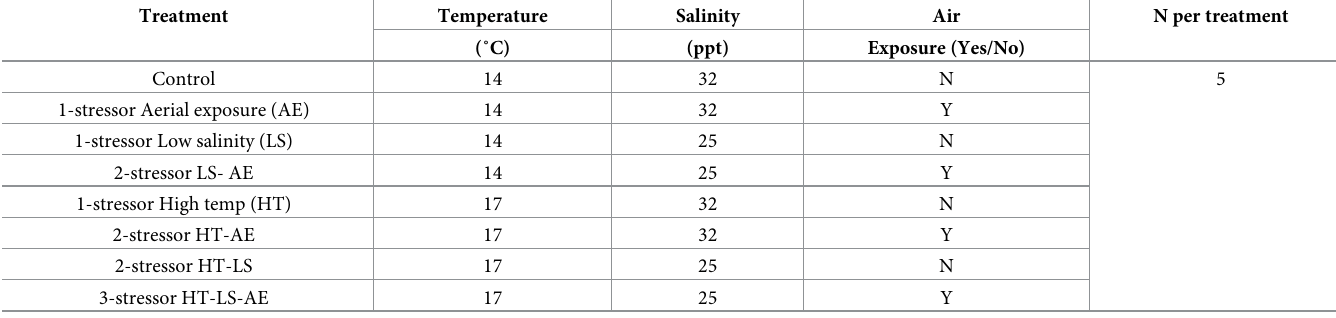
Table 1. Experimental design for wet lab